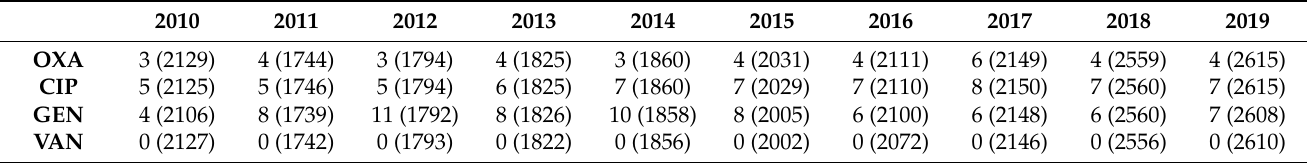
Table 6. Resistance of Staphylococcus aureus to antibiotics at the University Hospital Olomouc in 2010–2019. 2010